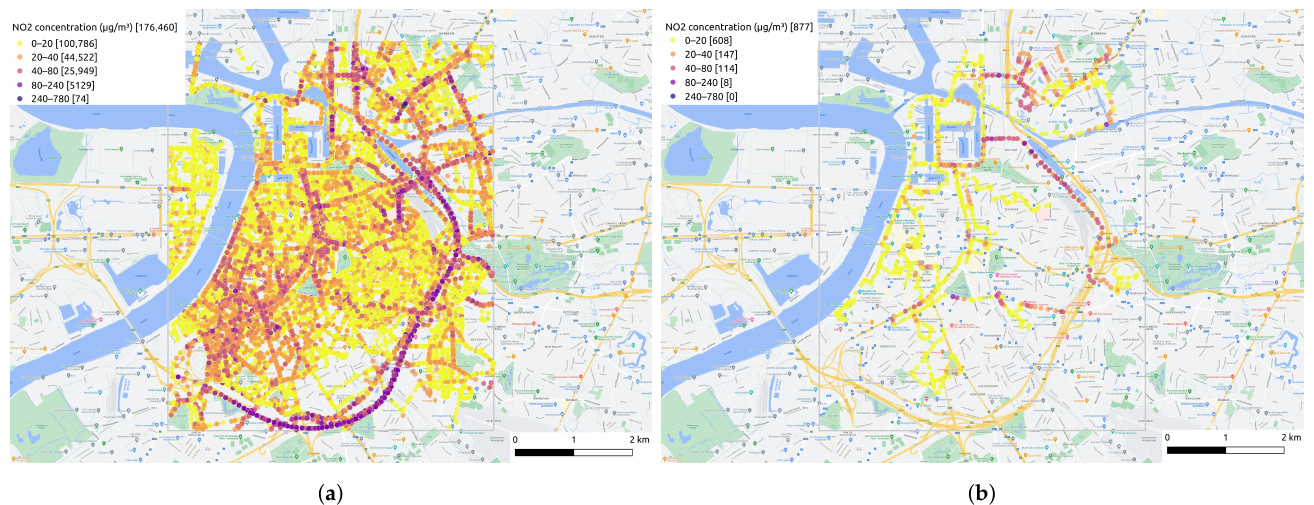
Figure 7. ( a ) The map of all aggregated NO 2 measurements after data processing procedures. ( b ) The map of aggregated NO 2 measurements at 11:00 on 9 June 2021. The color bar represents various NO 2 concentration level and the number followed means the amount of measurements at that